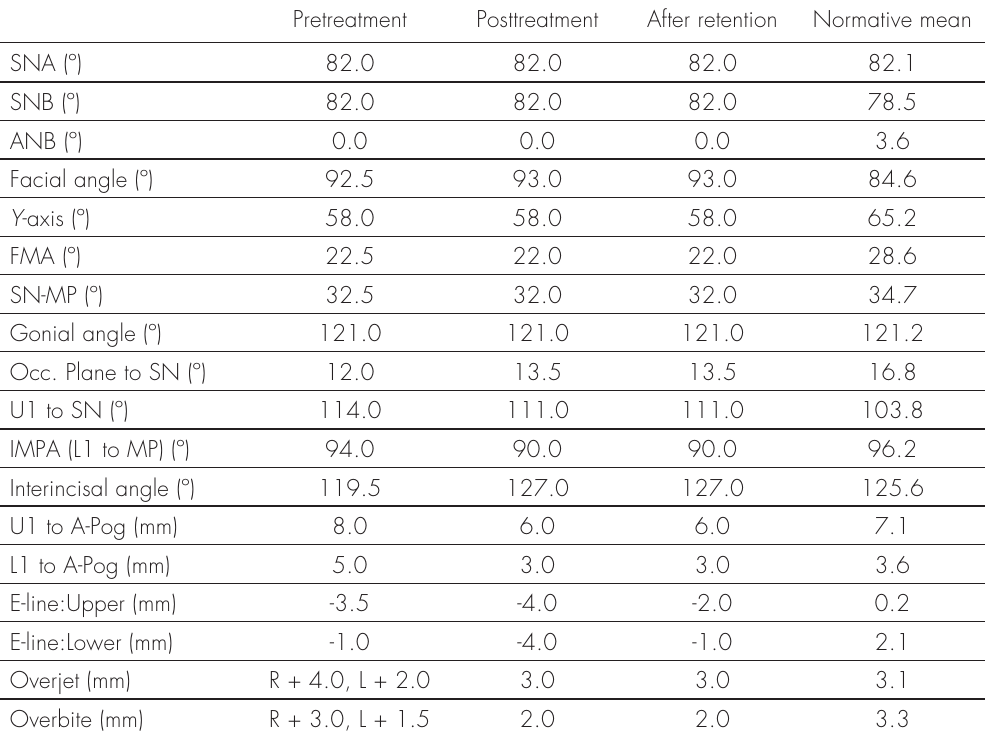
Table I. Cephalometric analyses